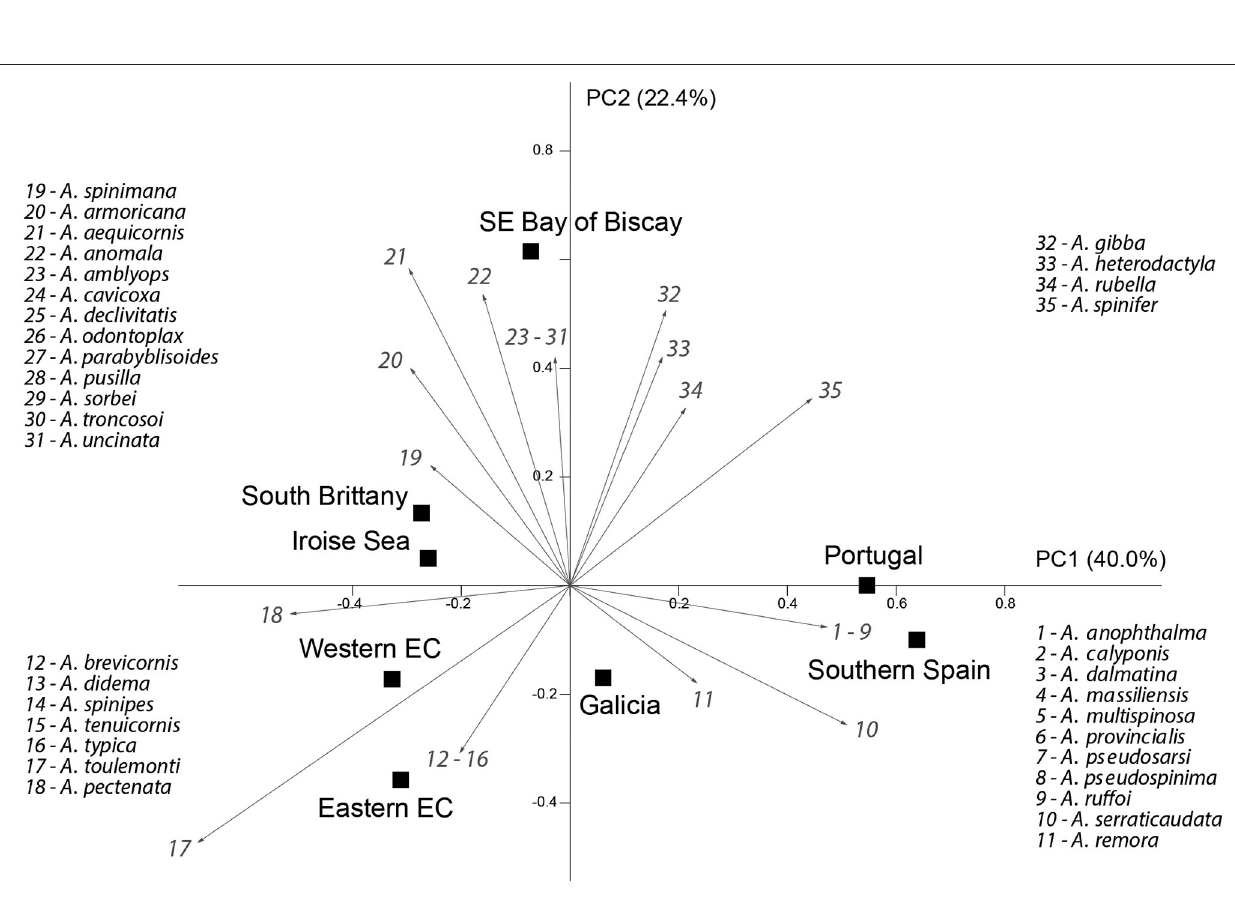
FIGURE 4 | Principal components analysis of the Ampelisca data from Table 1 . The analysis was performed with the full set of species but the figure excluded five species with eigenvectors bellow 0.1 ( A. eschrichtii , A. latifrons , A. lusitanica , A. sarsi and A. verga ). The vectors representing the species were amplified (x4) to clarify their position in relation to the